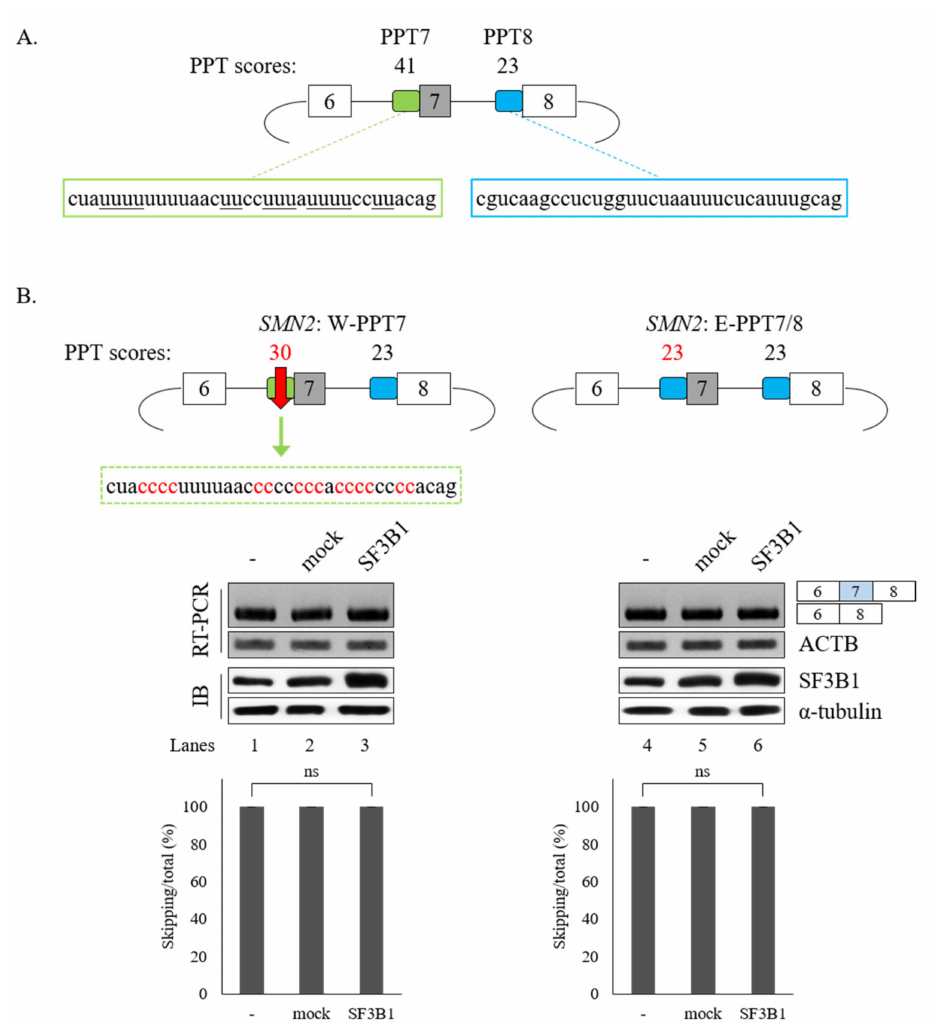
Figure 6. PPT sequences of cassette exon are essential for SF3B1 function in SMN exon 7 splicing. ( A ) Schematic representation of SMN2 minigene with PPT scores and sequences in exon 7 and exon 8. ( B ) (Upper) PPT scores and sequences of W-PPT and E-PPT7 / 8 mutants of SMN2 pre-mRNA. (Lower) RT-PCR analysis of W-PPT and E-PPT7 / 8 mutants with overexpression of SF3B1